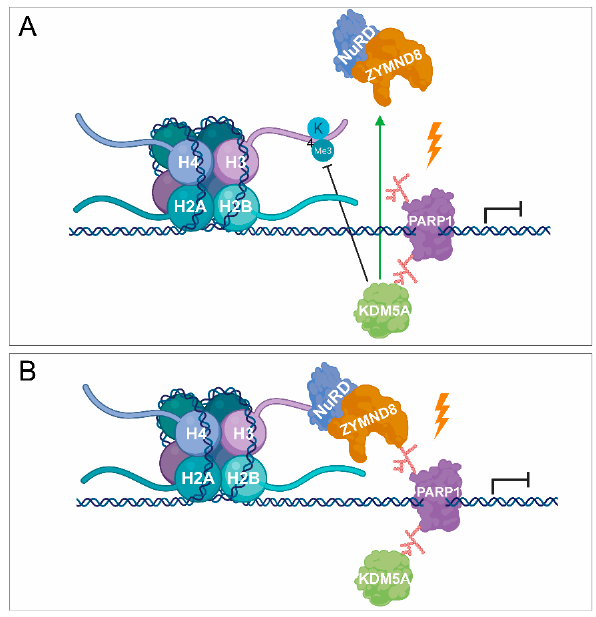
Figure 2. PARylation in transcription repression. ( A , B ) PARP1 is also involved in transcription silencing by recruiting demethylases, such as KDM5A, catalysing the removal of methyl groups and being responsible for transcription activation. KDM5A promotes the recruitment of NuRD and ZMYND8 to the lesion site by demethylating H3K4me 3 , thereby contributing to transcription silencing. By contrast, during NHEJ, the Ku70 / Ku80 heterodimers bind to the broken DNA ends